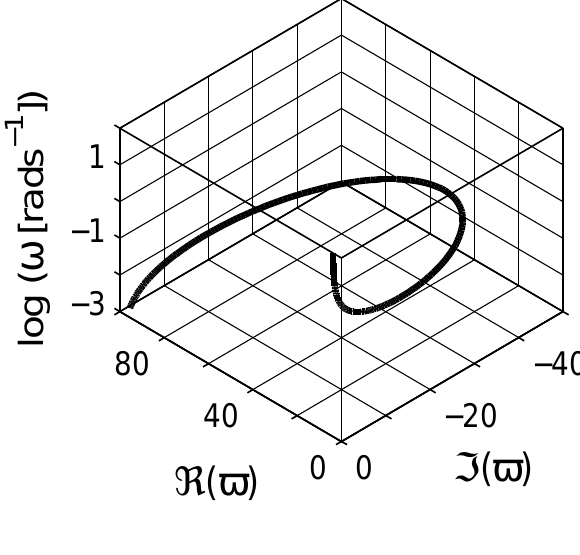
Figure 4 . Dependence of the real frequency ω as a function of complex “scaled” frequency (cid:36) in the spectral representation. Logarithmic scale is base